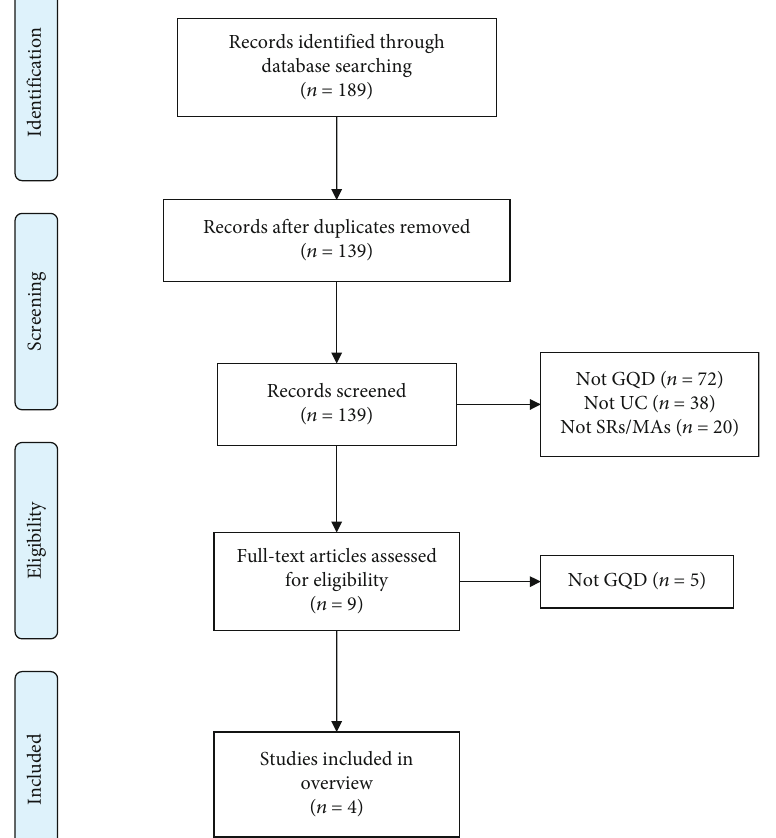
Figure 1: A fl owchart of the literature selection